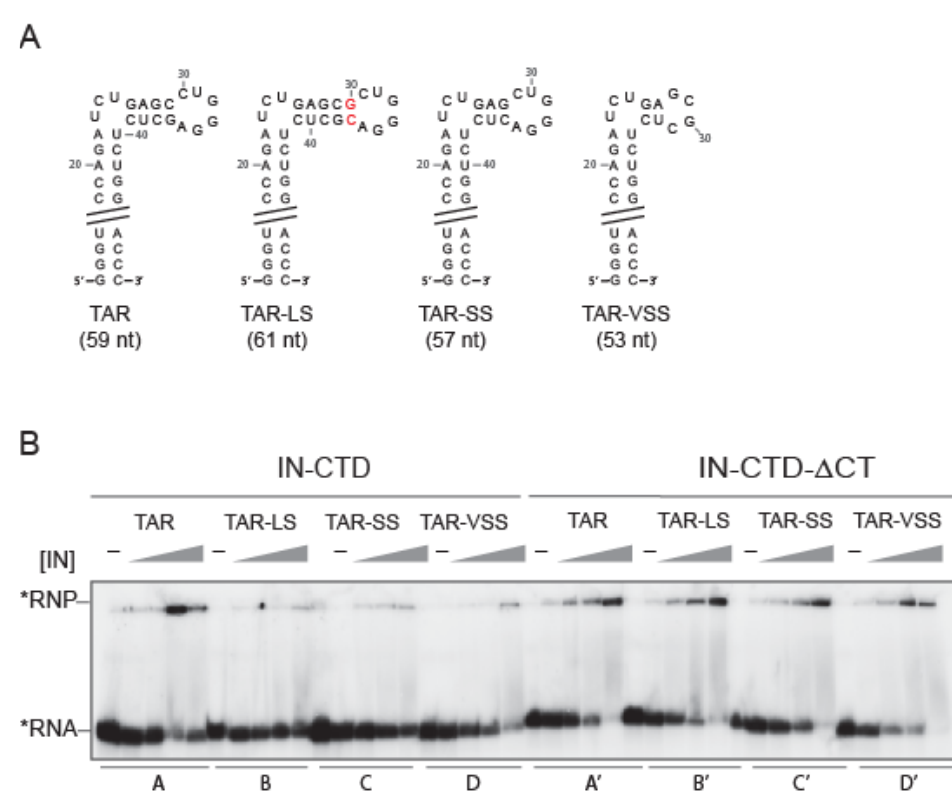
Figure 2. IN C-terminal tail sensing for TAR RNA apical stem-loop shape. ( A ) Structural model of TAR RNA and mutated versions used in our study: TAR long stem (TAR-LS, the red font underlines the added bases), TAR short stem (TAR-SS) and TAR very short stem (TAR-VSS). In order to verify that each RNA mutant assumed the expected secondary structure each model was analyzed with Fold WebServer [48,49]. ( B ) EMSA assay illustrating the interaction of IN-CTD and IN-CTD- ΔCT with TAR wild type and mutants. The RNA substrates (50 nM) are labelled with 32P (black star) and incubated with increasing concentrations of proteins (0; 100, 200, 400 and 800 nM) under the conditions described in ‘Materials and Methods’ section.